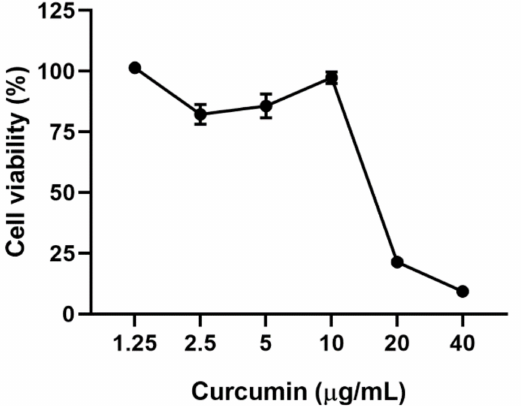
Figure 1. Cytotoxicity of curcumin on Vero E6. Viability of Vero E6 after 48 h of curcumin treatment (from 1.25 to 40 µ g/mL). Data were presented as Mean ± SEM. The viability percentages of the treated cell were calculated based on untreated control (n = 8).